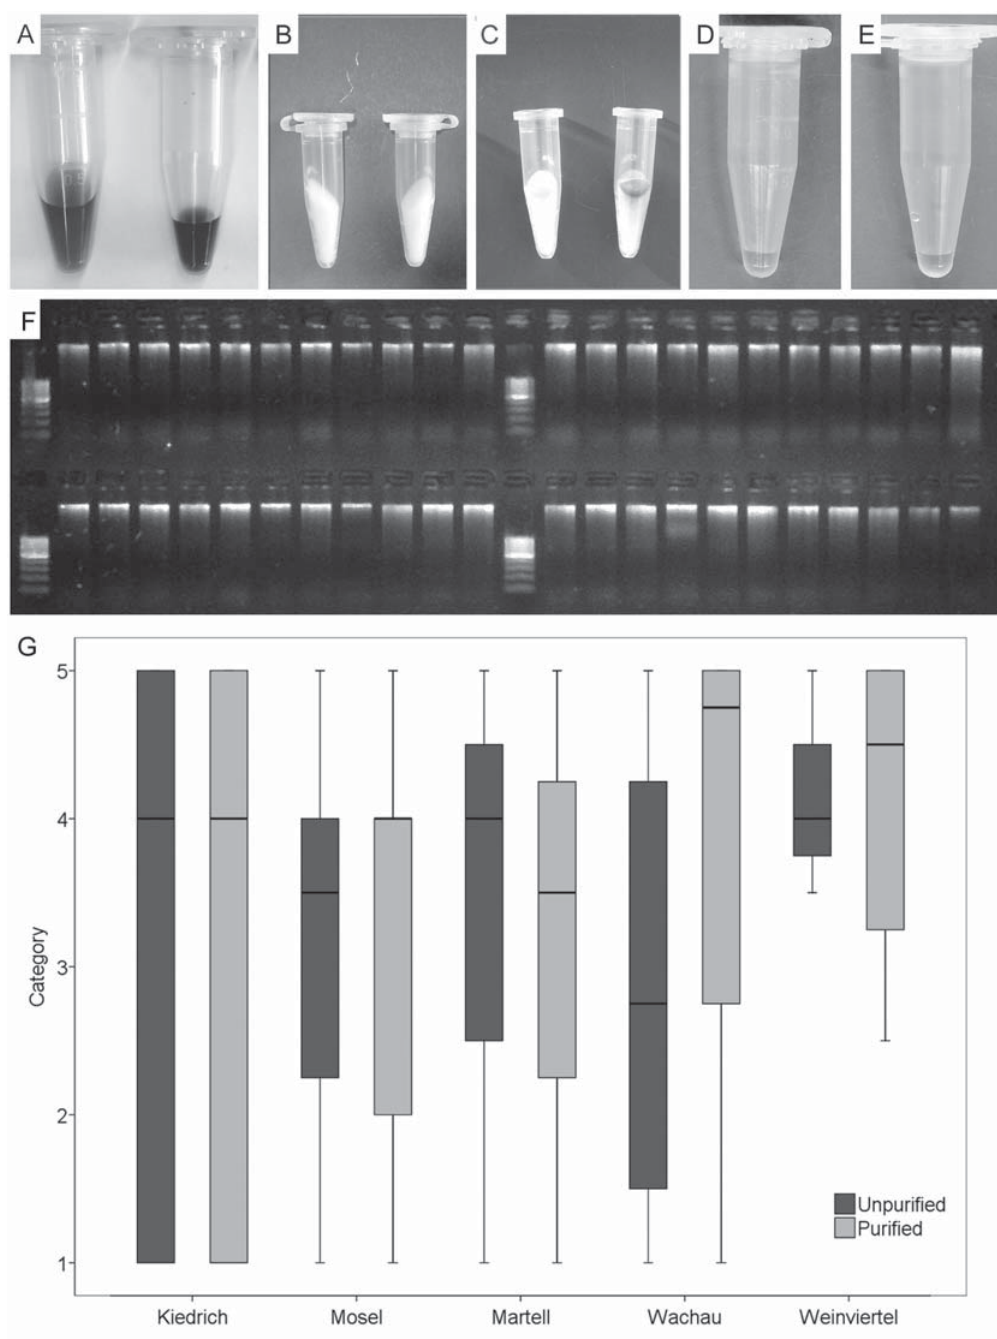
Fig. 3. DNA extract puri fi cation. (A) Unpuri fi ed DNA raw extracts. (B) PVPP spin-columns. (C) Dark substances of DNA extracts bound to the spin column. (D, E) Puri fi ed DNA extracts. (F) DNA raw extracts (upper row) and puri fi ed DNA extracts (lower row) on 1.5% agarose gel. (G) Ratings of unpuri fi ed and puri fi ed DNA extracts of different soil samples (n= 12 for each soil). Data are expressed as a box-and-whisker plot showing median, inter-quartile range (IQR), and extreme values. Atypical outliers are indicated with an open dot (values 1.5–3×IQR), extreme outliners with an asterisk (values >3×IQR). A fi ve-point-scale was used, whereby category one was assigned to bands with the highest